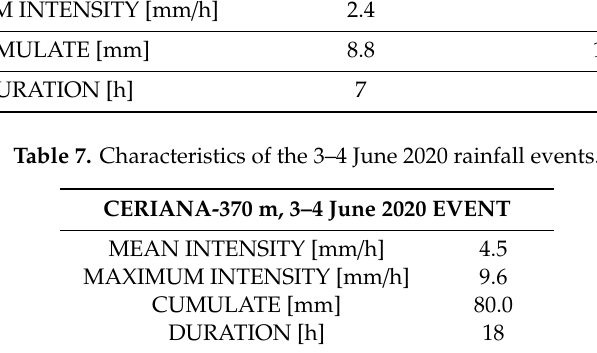
Table 6. Characteristics of the 16–17 May 2020 rainfall events.